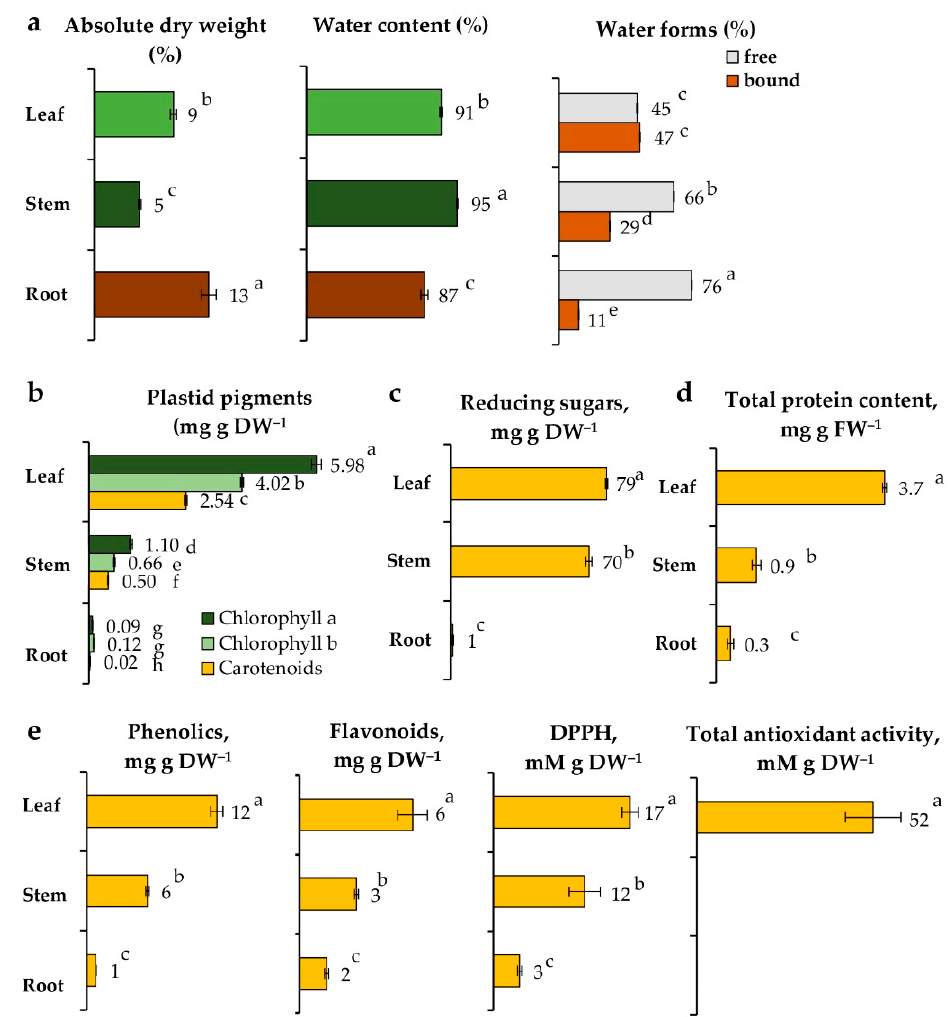
Figure 1. Biological traits of L. discolor grown in soil. ( a ) Absolute dry weight, water content, bound and free water; ( b ) Plastid pigments; ( c ) Reducing sugars; ( d ) Total protein; and ( e ) Secondary metabolites and antioxidant activity: total content of phenolic compounds and flavonoids, DPPH anti-radical and total antioxidant activities. Data represent the mean ± SE ( n ≥ 10). One-way ANOVA (Holm–Sidak) statistical test was applied to estimate the difference among all the variants. Different letters denote statistically significant differences. Scale bar: 5 cm.